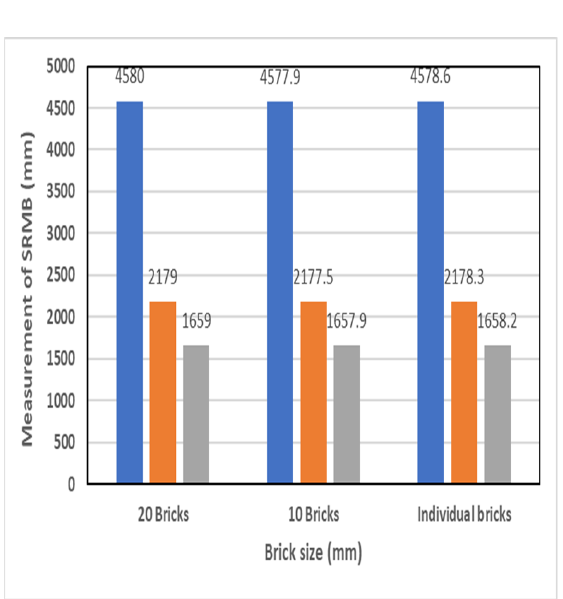
Figure 12. Variation in dimension results of sustainable red mud bricks.